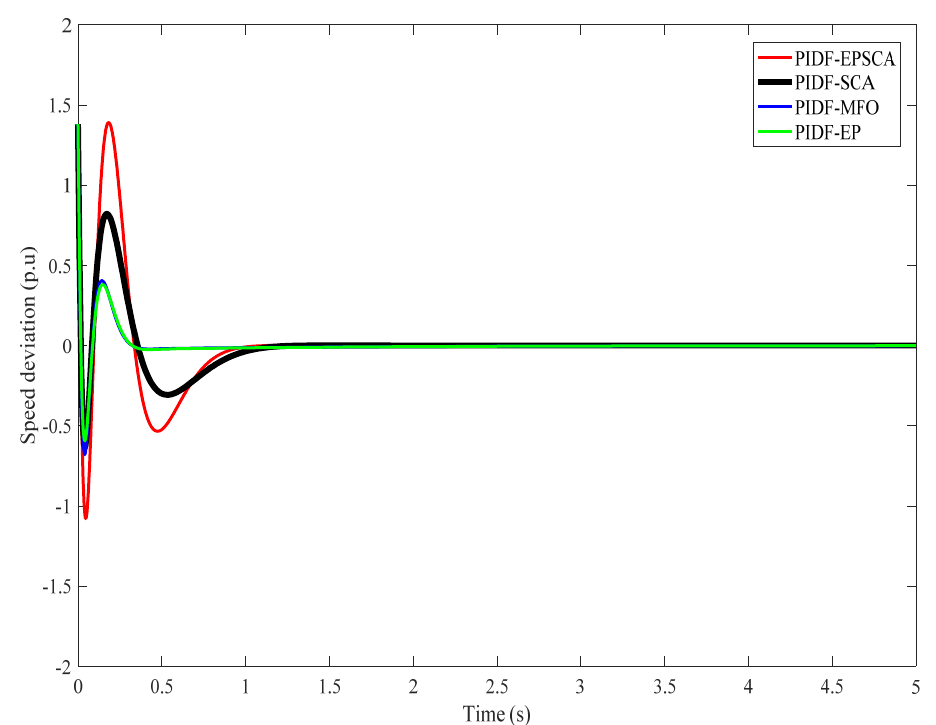
Figure 19. Speed deviation response of TCSC-PIDF controller using PIDF-EPSCA, PIDF-SCA, PIDF- MFO, and PIDF-EP techniques for Scenario A-2.